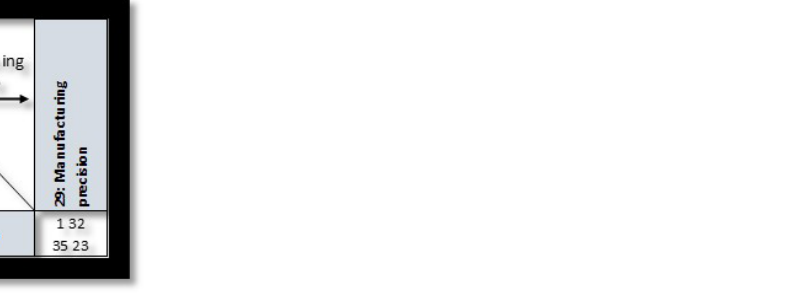
Figure 14. TRIZ Inventive Principles with Details to Address Technical Requirements Conflict